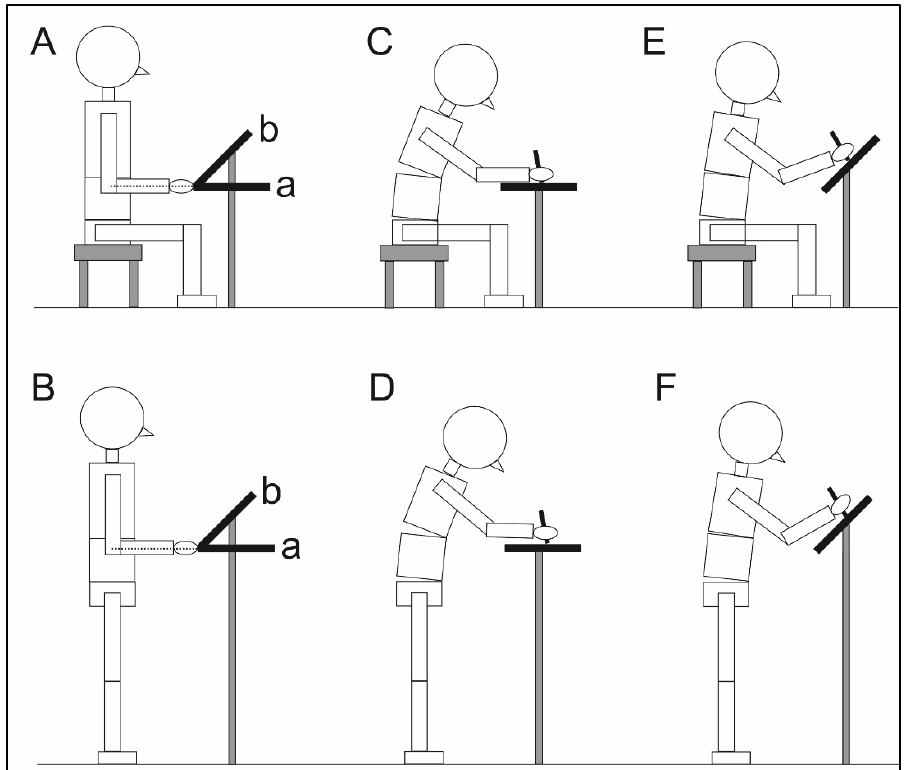
Figure 1. Experimental conditions. In the sitting condition, the subject sat on a height-adjustable stool with their hip, knee, and ankle joint flexed at 90 degrees (deg) ( A , C , E ). In the standing condition, the subject stood with their feet shoulder-width apart ( B , D , F ). In both the sitting and standing conditions, the tablet was firmly stabilized in the portrait orientation using a metal tablet stand; in the 0 deg condition, the tablet was fixed parallel to the floor (a in panels A and B), while in the 45 deg condition, the tablet was inclined to 45 deg and the lower edge of the device was matched with the 0 deg condition (b in panels A and B).